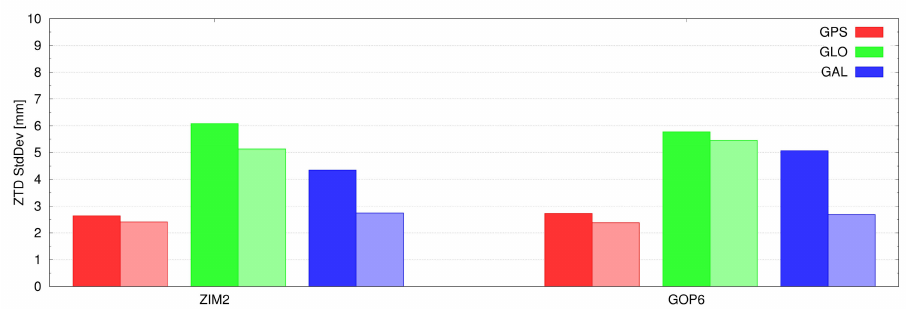
Figure 4. Standard deviation of the GPS, GLONASS (GLO) and Galileo (GAL) standalone Zenith Total Delay (ZTD) solutions with respect to the multi-GNSS solution. Dark color box is from data before 2019-02-11 and light color after that